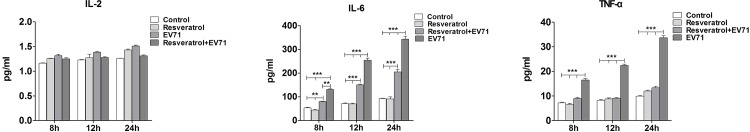
Promotion of IL-6 and TNF-α releases in RD cells with EV71 infection.Control: uninfected RD cells; Resveratrol: uninfected RD cells treated with resveratrol; EV71: EV71 infection; Resveratrol + EV71: RD cells pretreated with resveratrol for 1.5 h before EV71 infection. The culture supernatants were harvested at 8, 12 and 24 h after infection to measure the release of cytokines by luminex fluorescent technique. The data were expressed as mean ± SE from three experiments and analyzed by two-way ANOVA with Bonferroni post-hoctests. *P < 0. 05; **P < 0. 01; ***P < 0. 001.